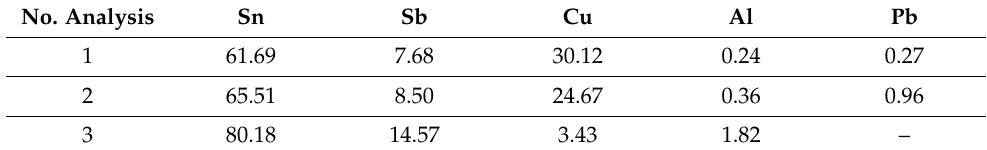
Figure 3. SEM image with marks highlighting different zones of EDS analysis of B83 babbitt before tribological tests. Table 4. EDX analysis of selected zones from Figure 3 on the raw surface of B83 babbitt, mass norm., %.